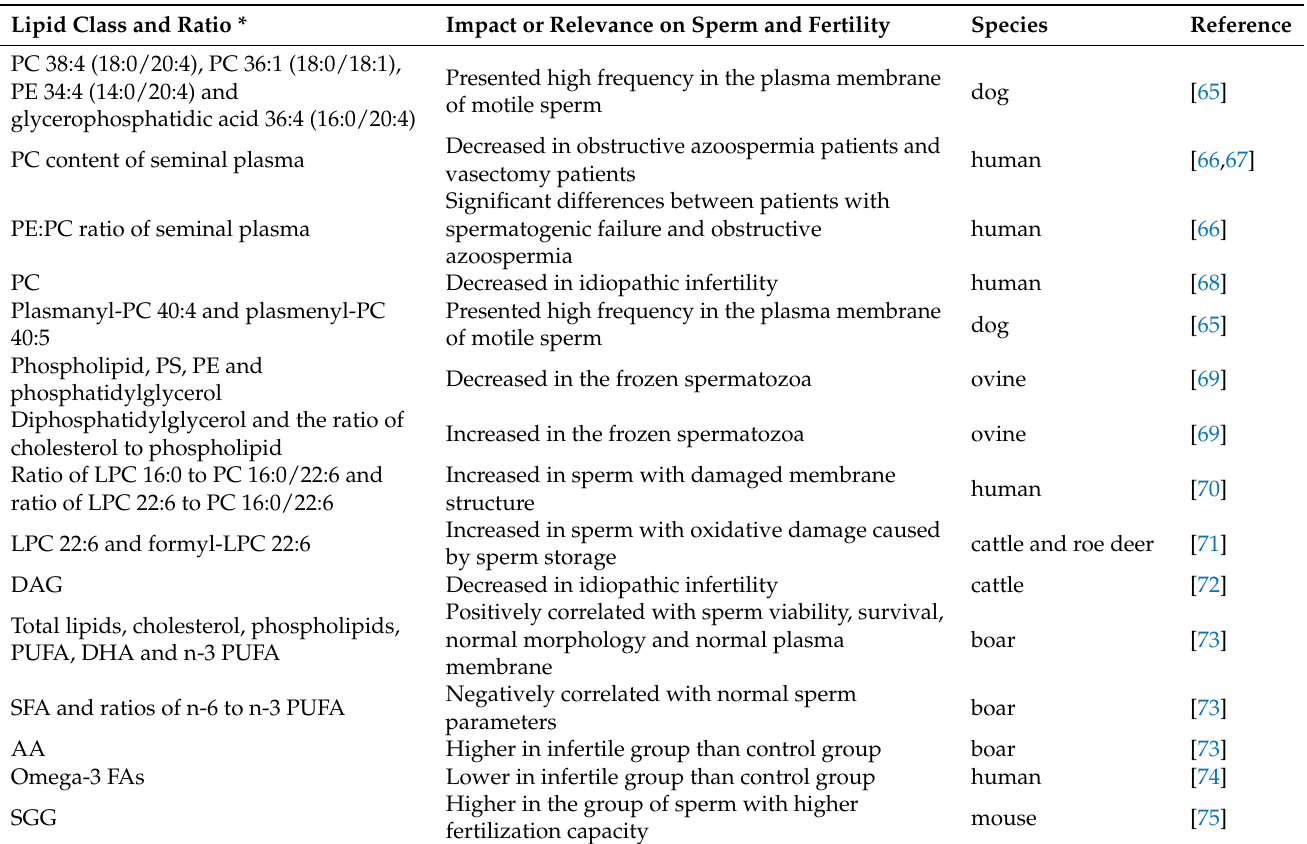
Table 1. Lipid markers associated with sperm function and